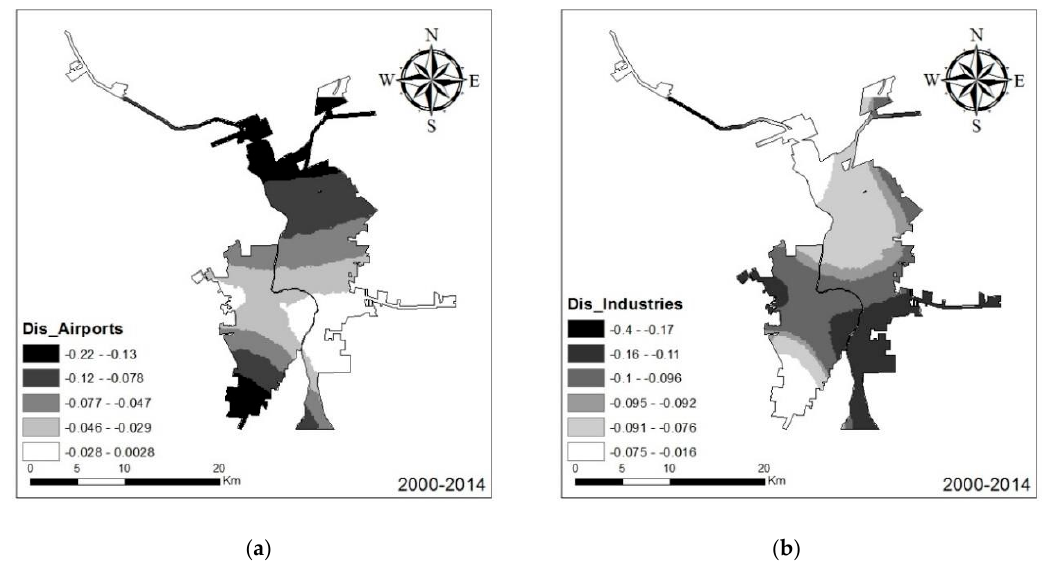
Figure 8. Logistic GWR results of the estimated coefficient: distance to the airports ( a ) and distance to the industrial sites ( b ), 2000–2014.